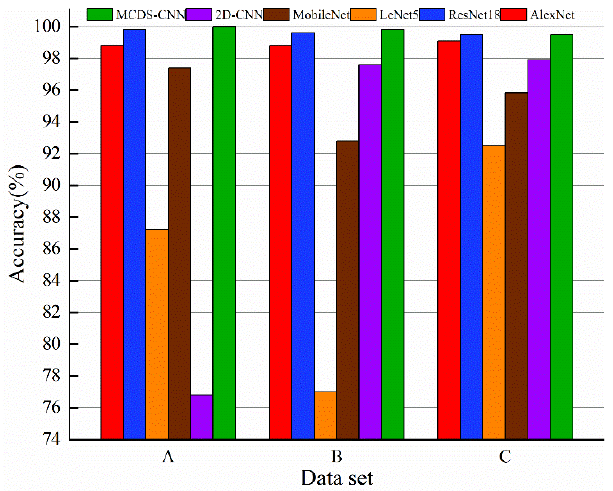
Figure 10. Accuracy comparisons between the proposed model, MCDS-CNN, and other five models on data set A, B, and C. Table 6. Ratio and other performances of the proposed model, MCDS-CNN, and other five models on data set A.